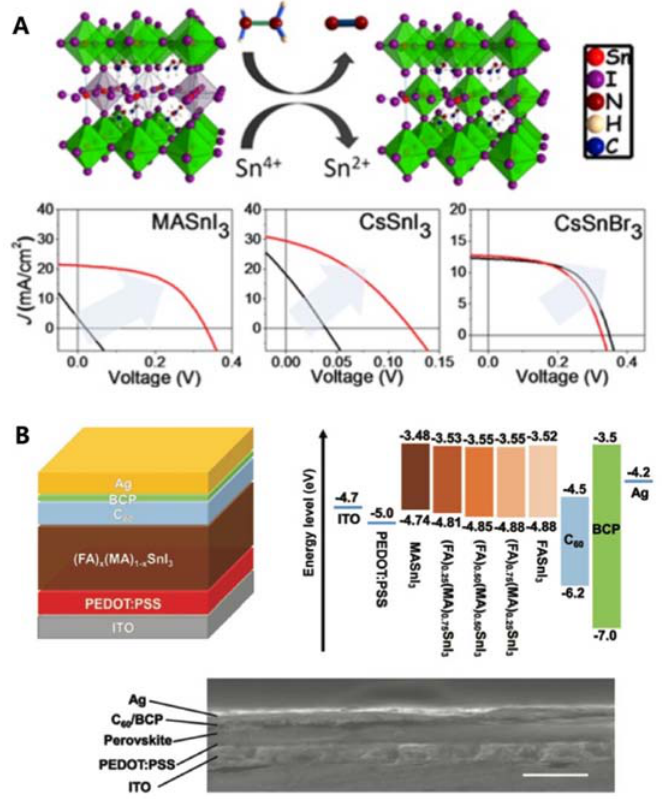
Figure 2. ( A ) Proposed mechanism of hydrazine vapour reaction with Sn-based perovskite materials (reduction process: 2SnI 62 − + N 2 H 4 → 2SnI 42 − + N 2 + 4HI). J–V curves for MASnI 3 solar cells, CsSnI 3 solar cells, and CsSnBr 3 solar cells with and without hydrazine vapour concentrations. Reprinted with permission from ref. [27] Copyright 2017, The American Chemical Society. ( B ) Schematic of the device structure, band alignment diagram, and a cross-sectional scanning electron microscope image of a completed device (scale bar: 500 nm). Reprinted with permission from ref. [30]. Copyright 2017, the John Wiley and Sons.